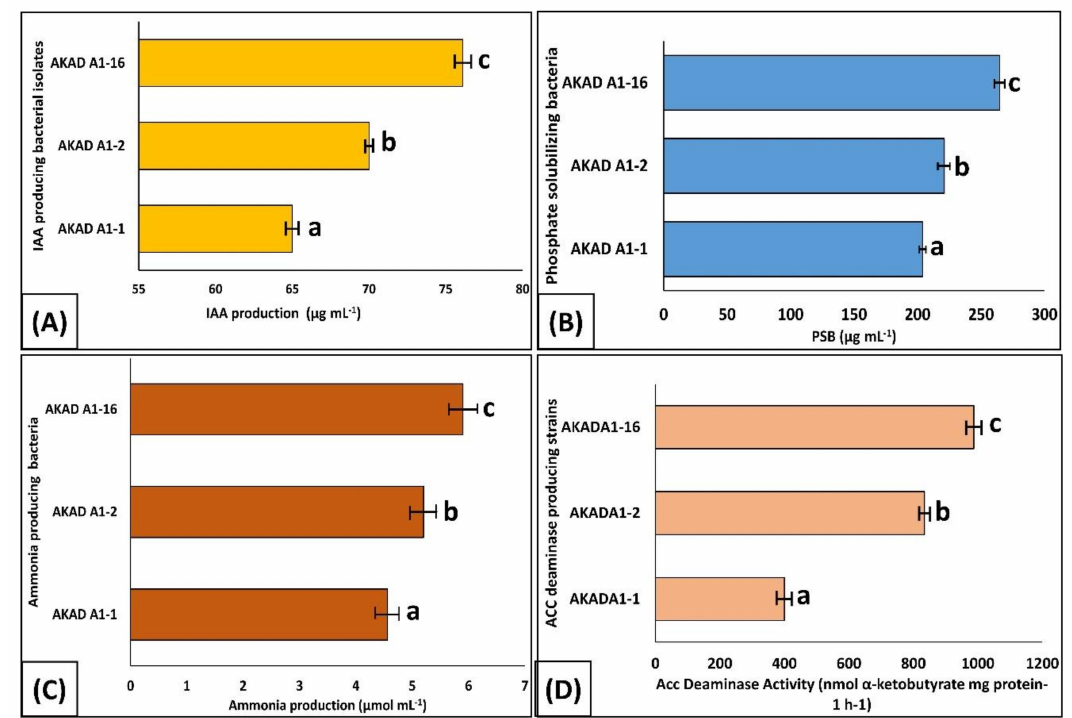
Figure 4. Plant growth-promoting activities of bacterial endophytes: ( A ) IAA production, ( B ) PSB activity, ( C ) ammonia production, ( D ) ACC deaminase activity. Note: Different letters in rows show that values are significantly different ( p ≤ 0.05) from each other as evaluated using DMRT (Duncan’s multiple range test). The values are the means of three replicates ± SD ( n = 3).